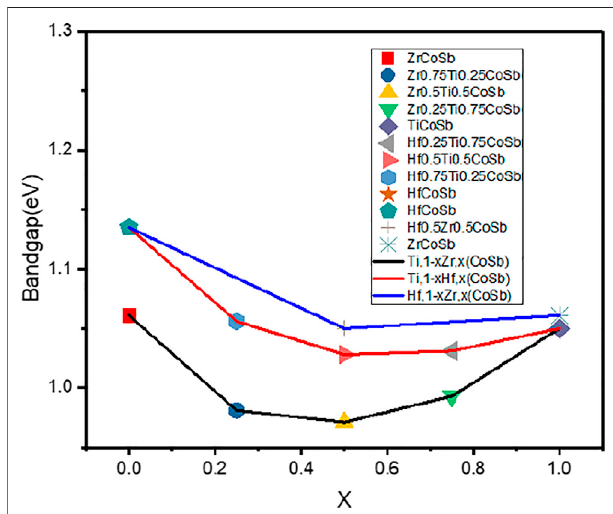
FIGURE 3 | Graph plot based on data by Joshi and co-workers (Joshi et al., 2019).